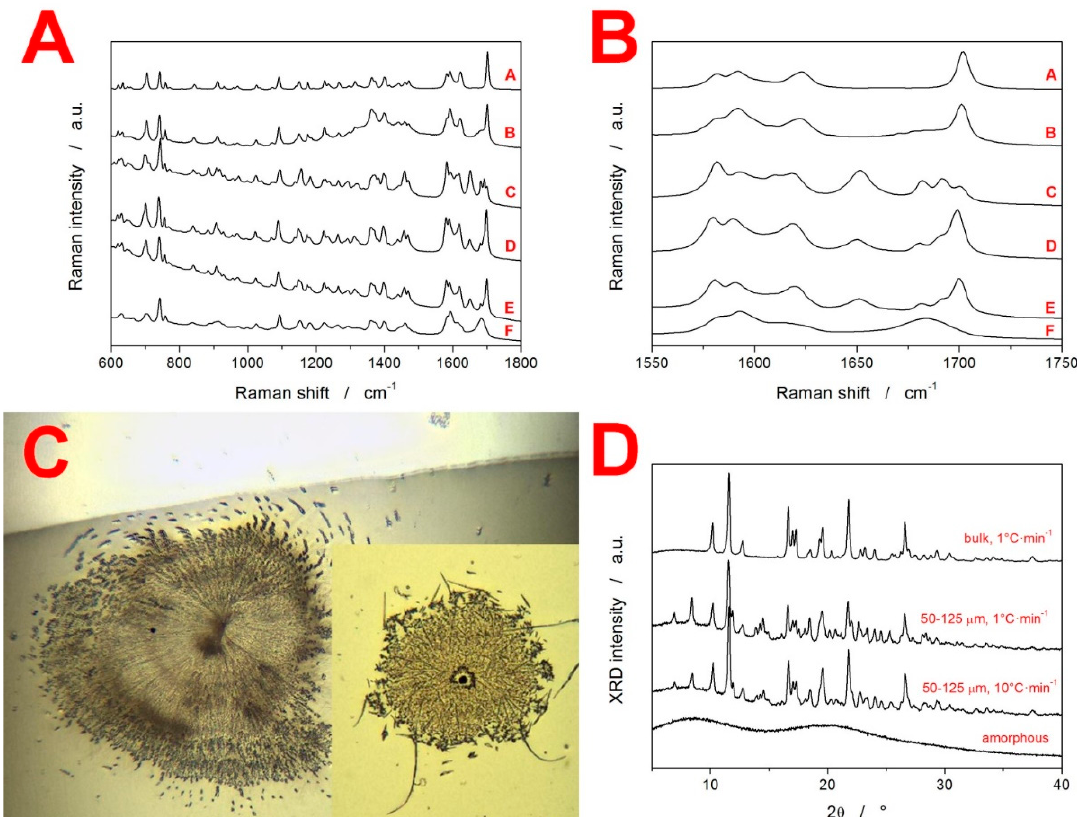
Figure 3. ( A ) Raman spectra for different types of IMC samples: A = original crystalline γ -IMC used to prepare the amorphous IMC, B = bulk IMC aged at room temperature for 48 h and DSC-crystallized at 10 °C ∙ min − 1 , C = 50–125 µm IMC powder aged at room temperature for 48 h and DSC-crystallized at 10 °C ∙ min − 1 , D = fresh 50–125 µm IMC powder DSC-crystallized at 1 °C ∙ min − 1 , E = fresh 50–125 µm IMC powder DSC-crystallized at 10 °C ∙ min − 1 , and F = amorphous IMC. ( B ) Raman spectra from graph A, zoomed-in on the 1550–1750 cm − 1 range of the Raman shift. ( C ) Optical micrographs of the γ -IMC and possible τ -IMC (inset) crystals grown on the free bulk IMC surface. ( D ) XRD patterns obtained for the amorphous IMC, and IMC samples crystallized under various conditions.